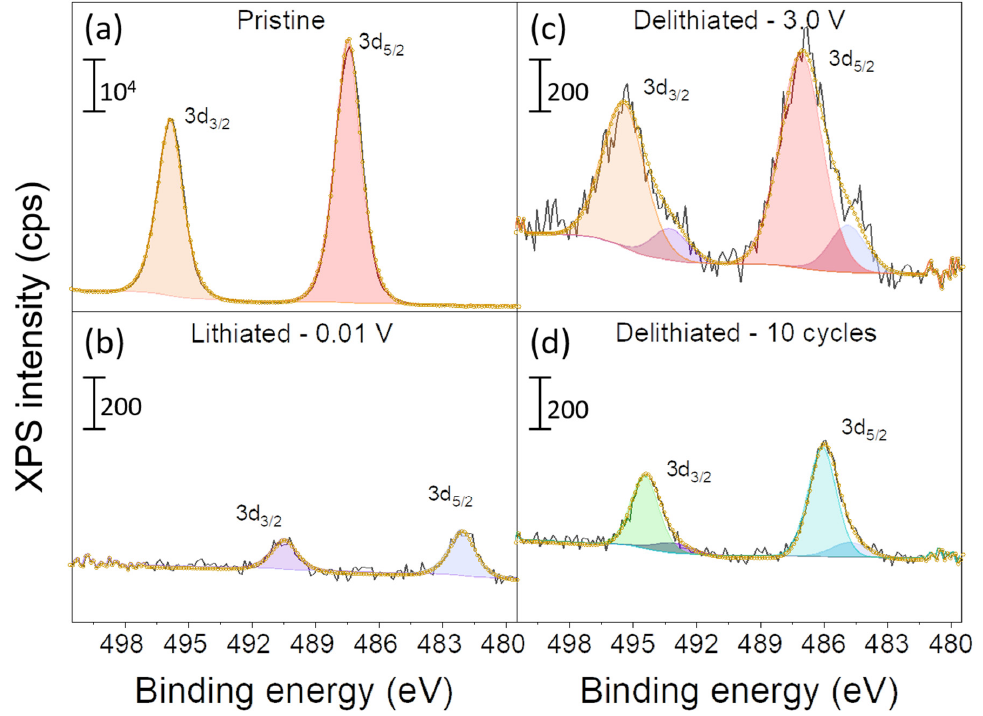
Figure 5. XPS detail spectra in the Sn3d region recorded for ( a ) a pristine electrode, ( b ) at the fully lithiated state (0.01 V), as well as ( c , d ) at the fully delithiated state (3.0V) ( c ) after one cycle and ( d ) after 10 cycles.